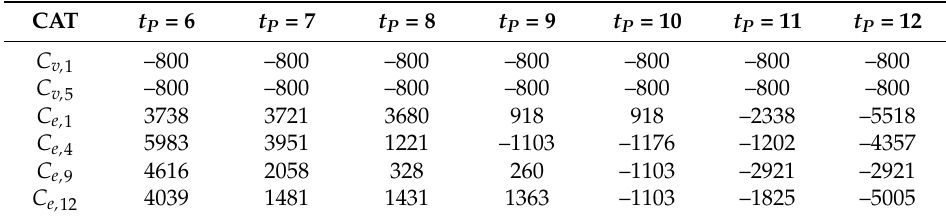
Table 5. LSE’s daily loss with contingency anticipation time in the modified IEEE 118-bus system ($).